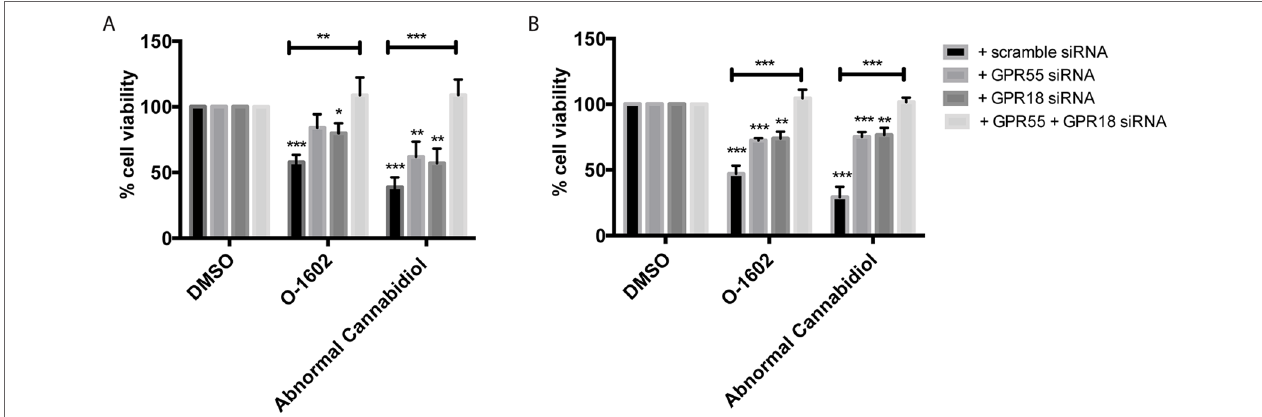
FIGURE 4 | Receptor dependence of effect on cell viability. (A) Effect of the GPR55-, GPR18-specific small interfering RNAs (siRNAs), or combination of siRNAs for both targets on cell viability in (B) MDA-MB-231 PR cells and (B) MCF-7 PR cells. * p < 0.05, ** p < 0.01, *** p < 0.001.